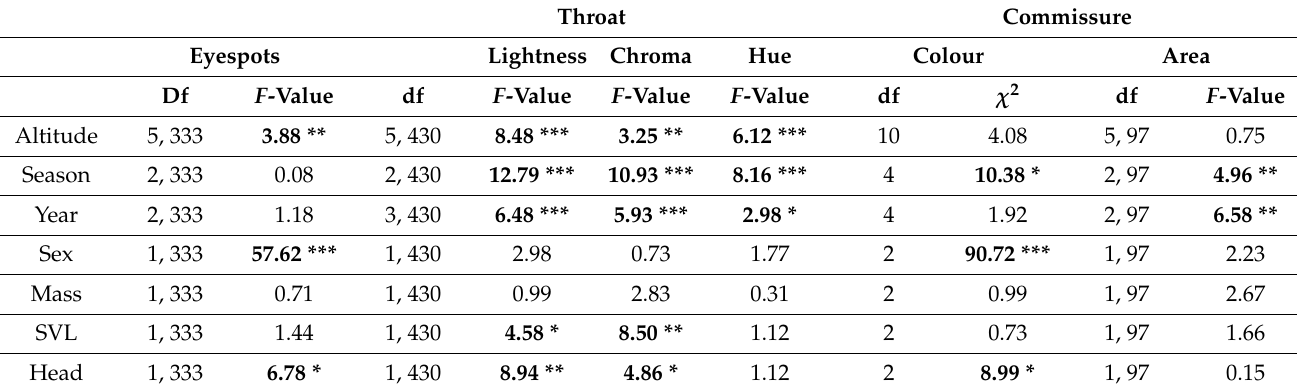
Table 2. Full models for each colour variable. In bold, predictors with a significant effect. Degree of freedom (df) as well as F -value for lineal models and χ 2 for multinomial model are shown. * p < 0.05, ** p < 0.01, *** p <